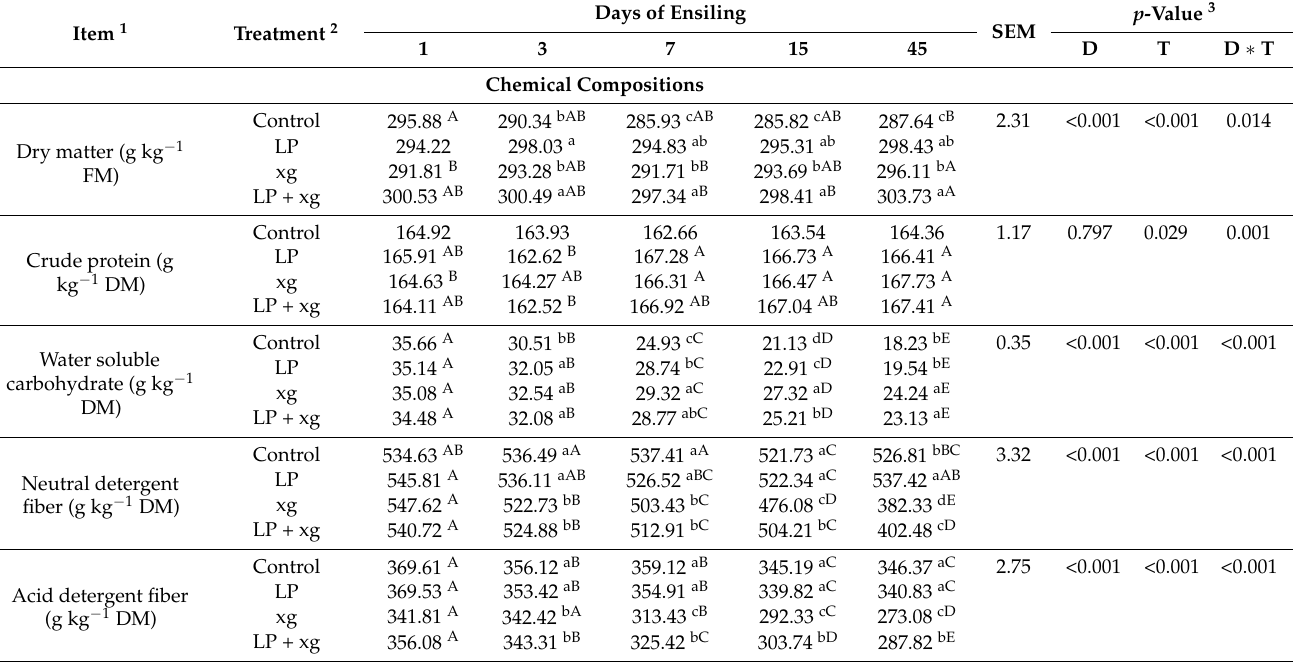
Table 5. Changes in chemical compositions during the ensiling of high–moisture Stylosanthes